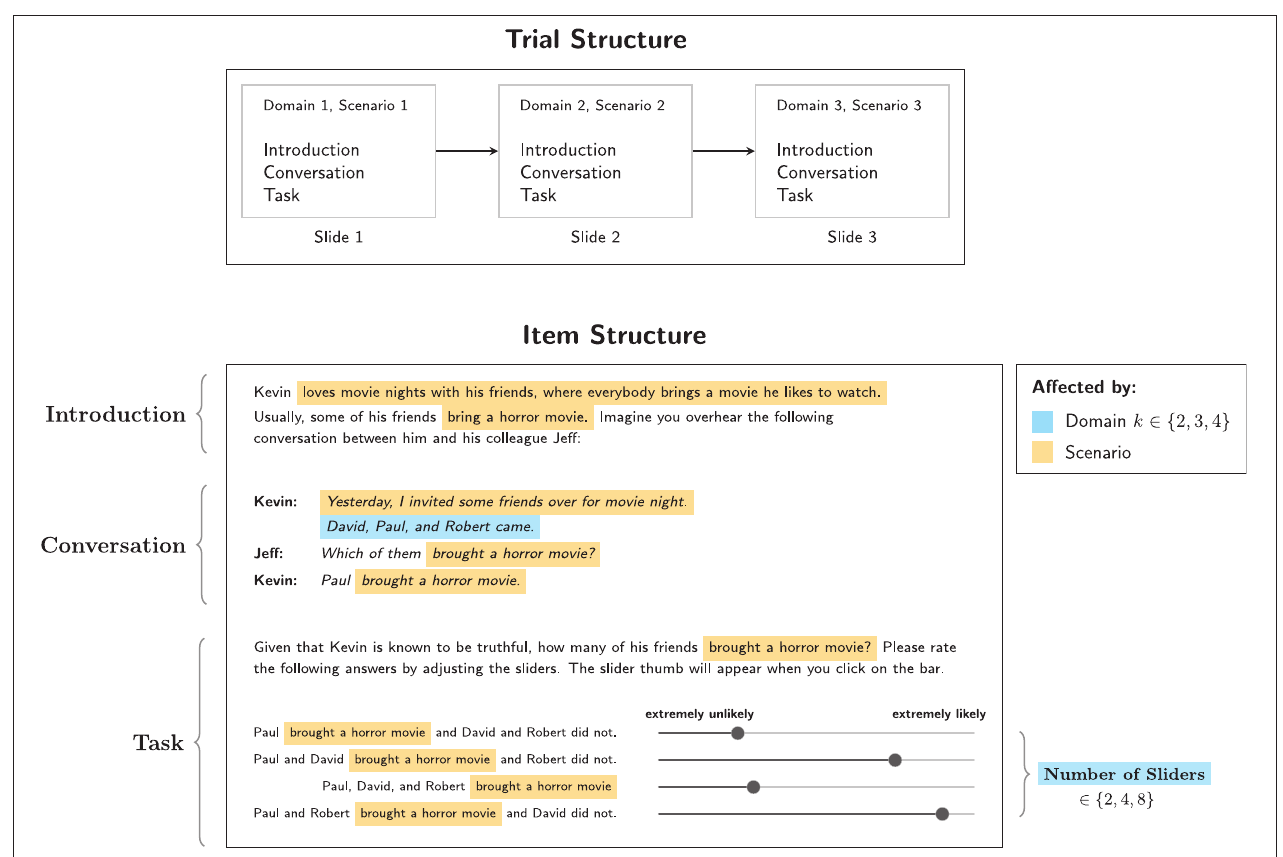
FIGURE 2 | Structure of trials in Experiment 1. Also shown is the structure of items for posterior elicitation, where the elements that are affected by the choice of domain size and scenario are highlighted.